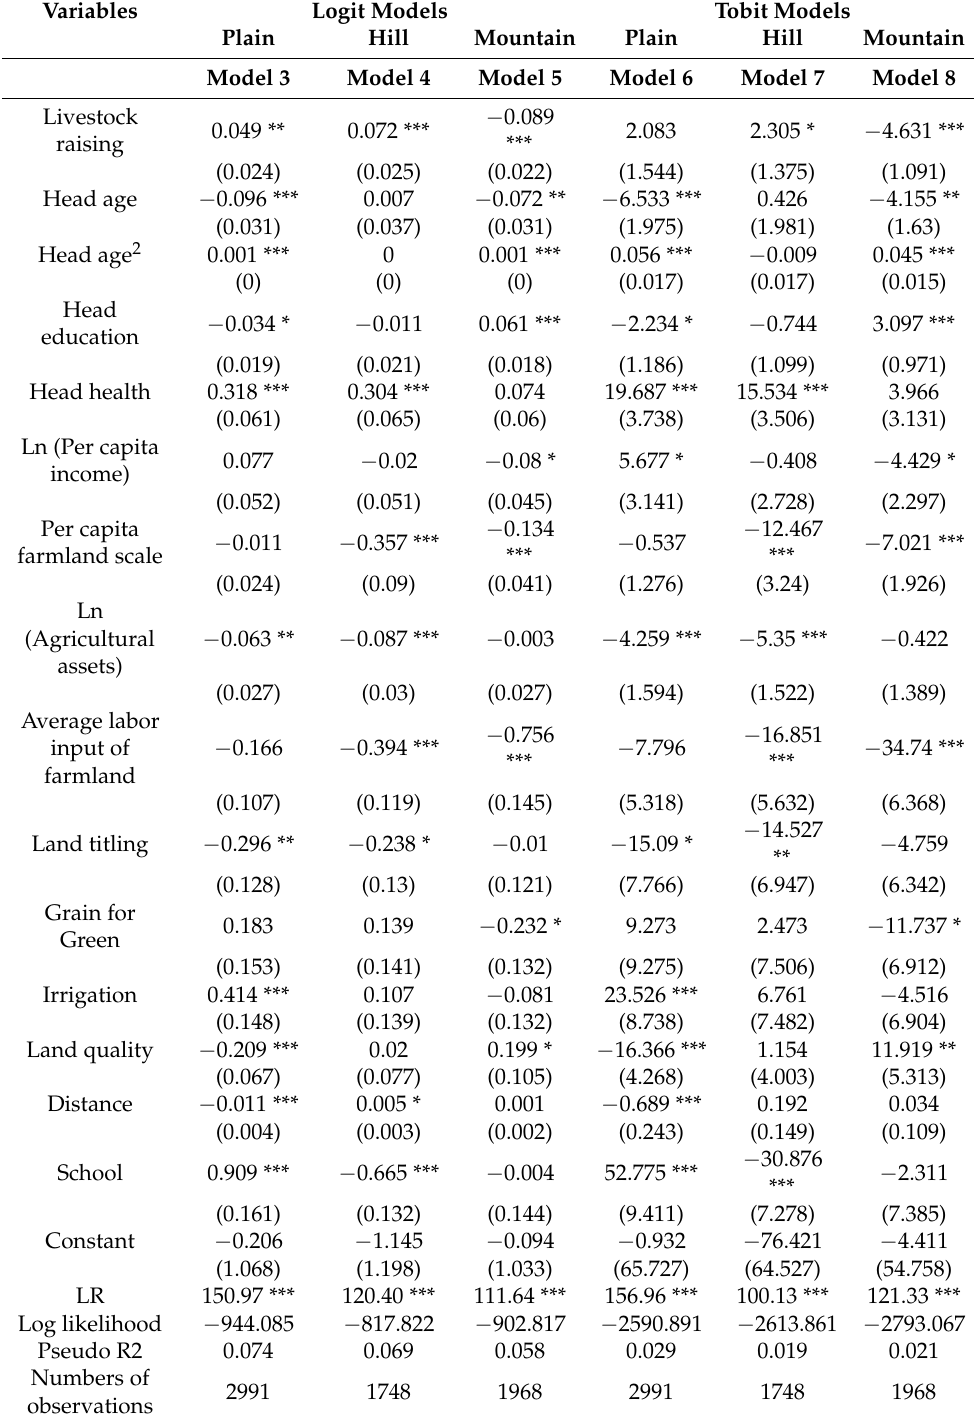
Table 3. Estimation results of the Logit and Tobit